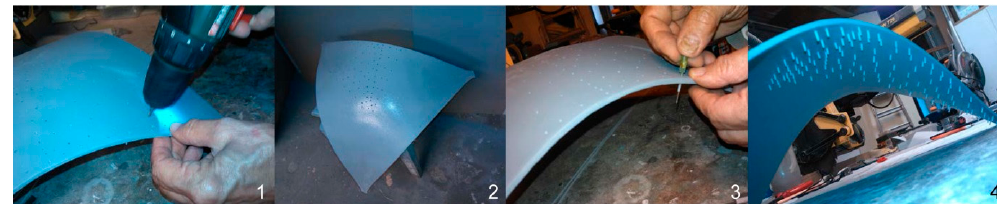
Figure 11. Installation of pressure sensors: ( 1 ) drilling; ( 2 ) painting with coating; ( 3 ) installation of pressure sensors; and ( 4 ) final instrumented model.